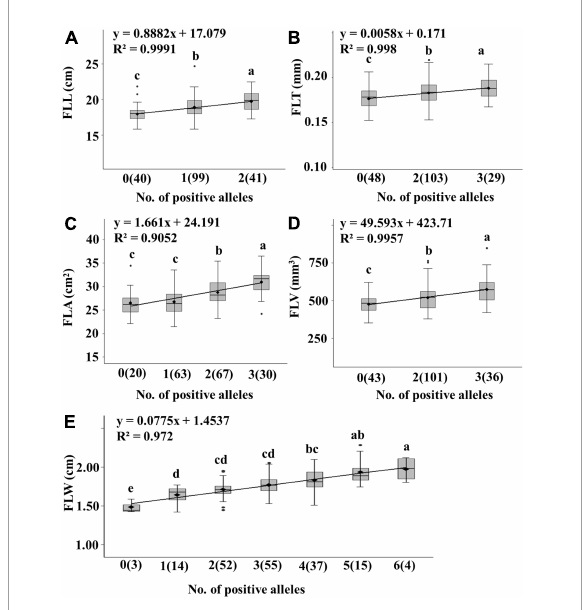
FIGURE4 Linear regressions between number of positive alleles and trait values for five flag related traits in the Jinchun 7 × Jinmai 919 DH population (A–E) . The number of lines carrying the corresponding number of positive alleles are shown in brackets. The letter above the bars indicated comparisons result at the significant level 0.05.